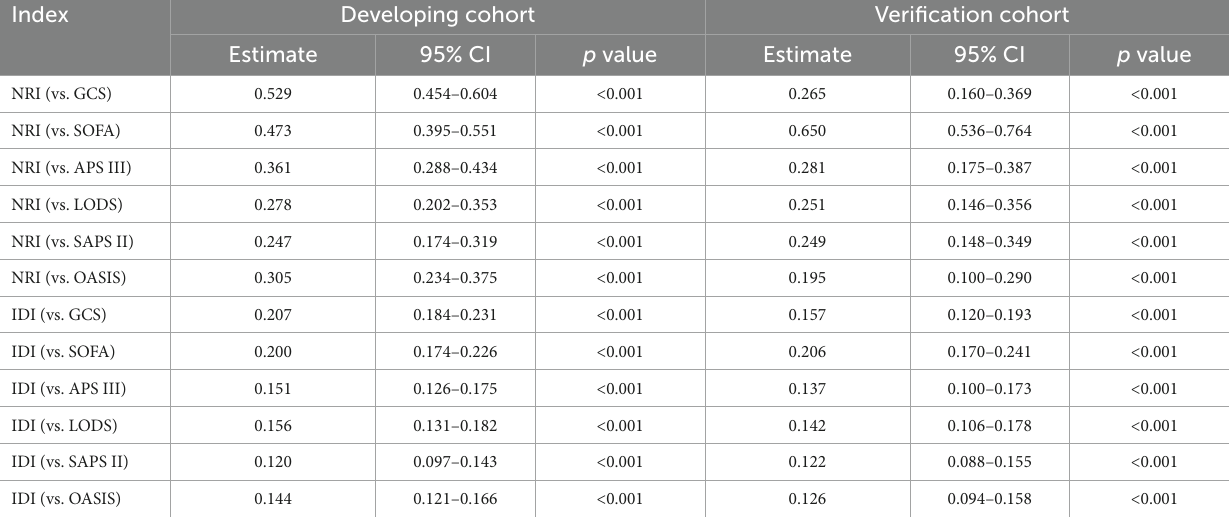
TABLE 4 Comparison of NRI and IDI models for predicting the 1-year mortality in patients with ischemic stroke.